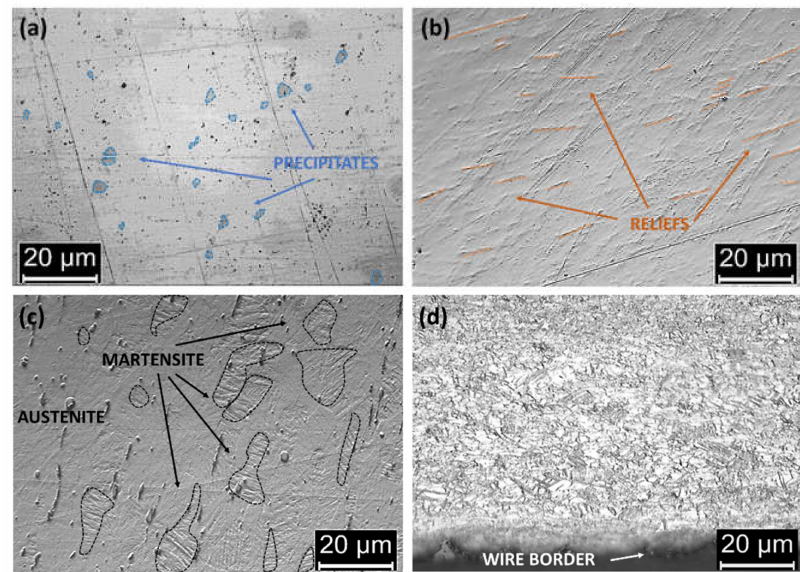
Figure 5. Representative light micrographs at 1000 × magnification of ( a ) polished NiTi_Azdent with precipitates (blue dashed circles) and ( b ) polished β -Ti_Ormco with parallel reliefs (orange dashed line), ( c ) etched NiTi_Vis Plus with martensite lamellae regions (dashed black circles) and ( d ) small grains are visible near etched β -Ti_Azdent wire border, whose composition needs further analysis. The scale bar is 20 µ m.